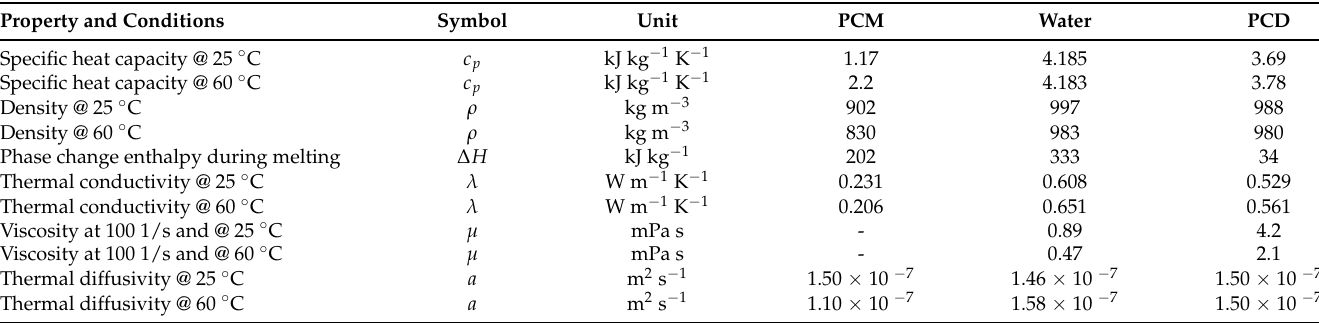
Table 2. Thermophysical properties of the phase change material (PCM), water and the phase change dispersion (PCD) used in this investigation from